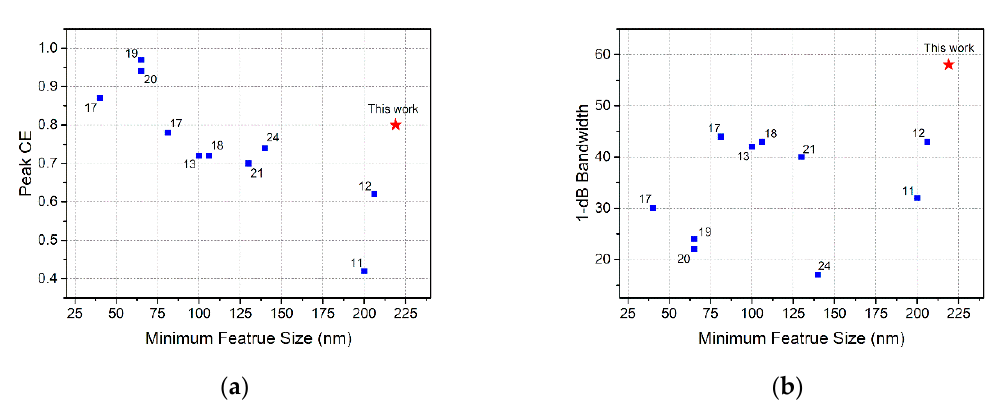
Figure 1. Comparison of our perfectly vertical grating coupler (GC) simulation result, with previously reported works with different minimum feature size: ( a ) coupling efficiency; ( b ) 1-dB bandwidth. The numbers next to the markers are the references.